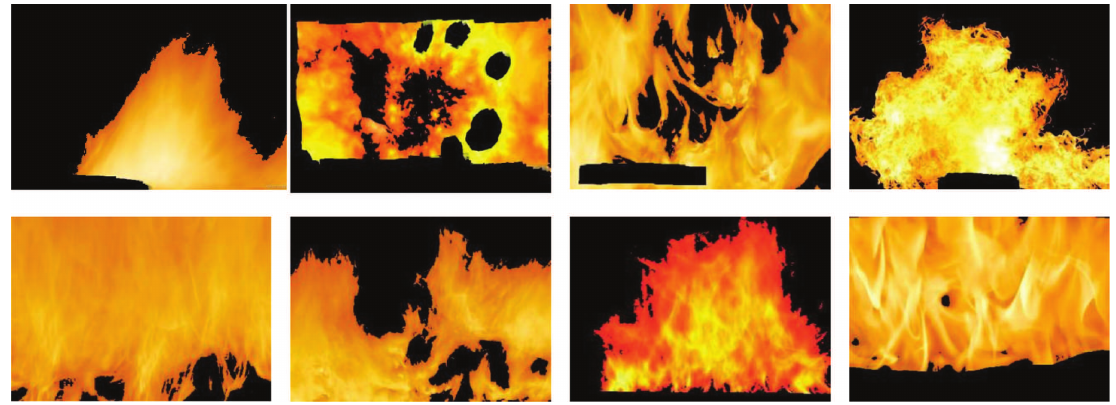
Figure 3: Marked Flame Pixels.